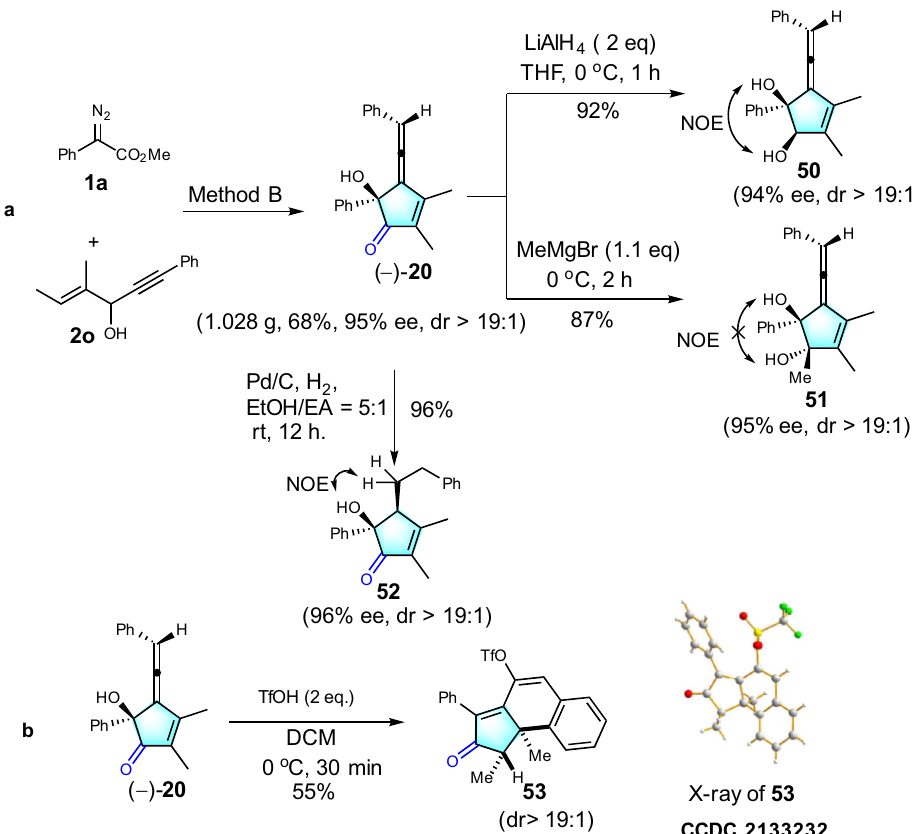
Fig. 7 Gram scale and synthetic application. a Gram scale and Reduction reaction. b Tandem cyclization reaction induced by